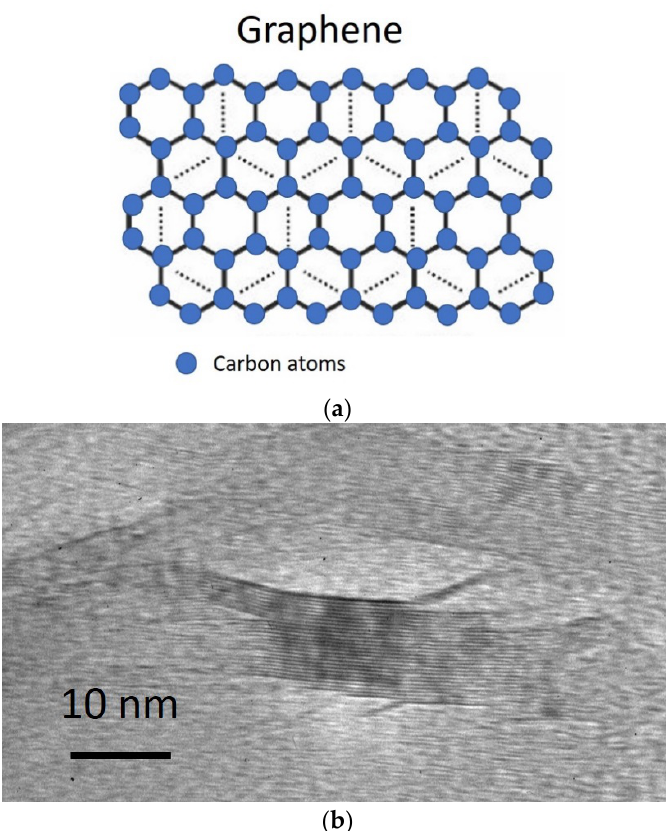
Figure 1. Structure of multilayered graphene. ( a ) Schematic view, ( b ) TEM